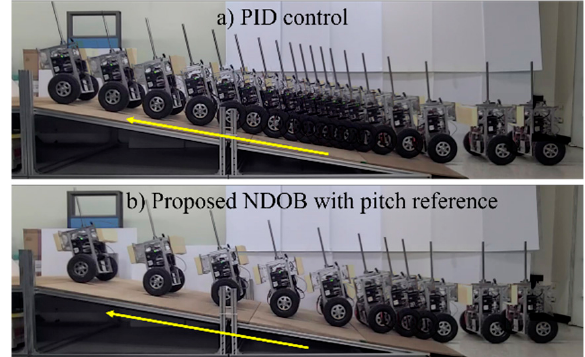
Figure 14. Effect of the terrain uncertainty during uphill driving.